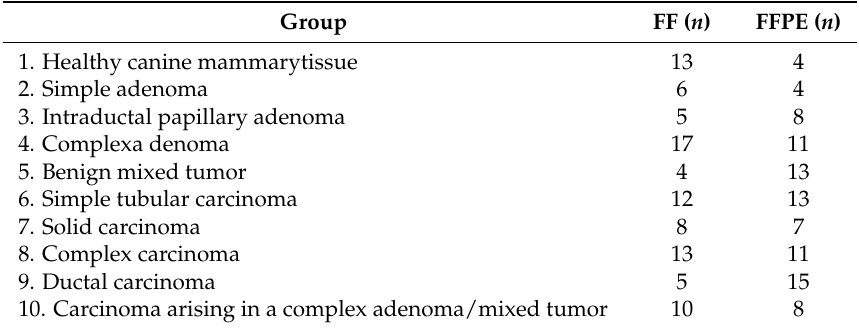
Table 1. Histological groups based on Goldschmidt et al. [20] with their respective number of samples for FF and FFPE specimens. n ě